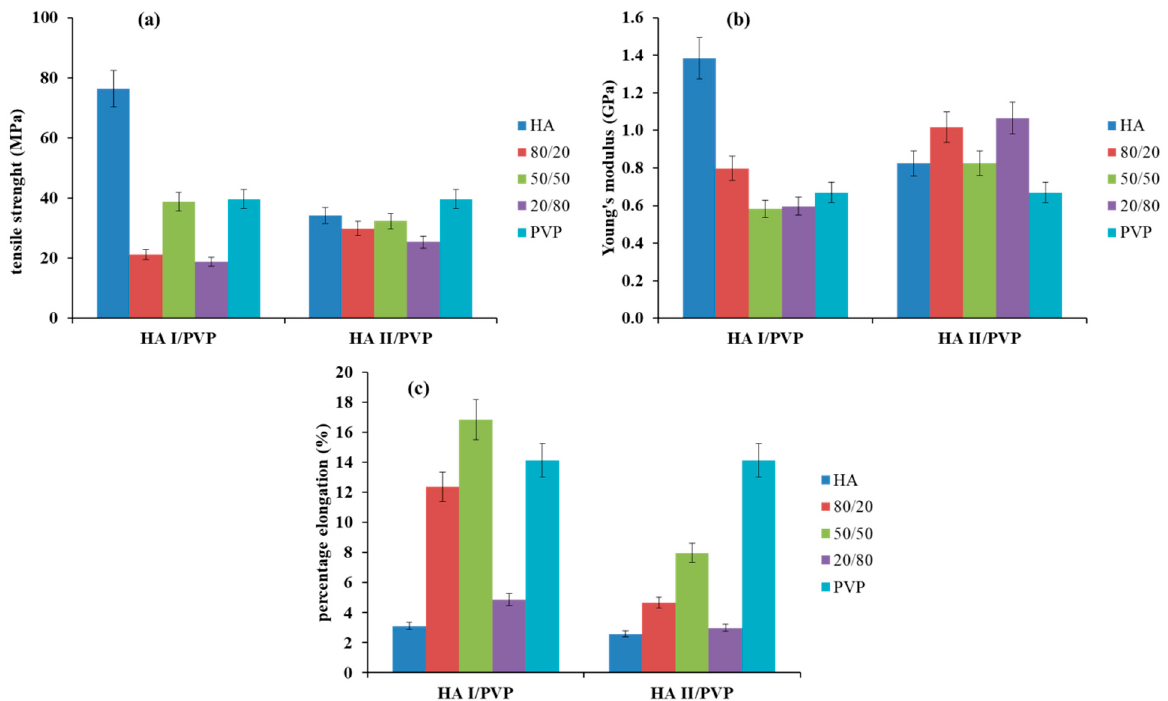
Figure 3. Mechanical properties of HA, PVP and HA/PVP blends: ( a ) tensile strength (TS), ( b ) Young’s modulus (YM) and ( c ) percentage elongation at the break (EB). w HA —HA weight fraction.